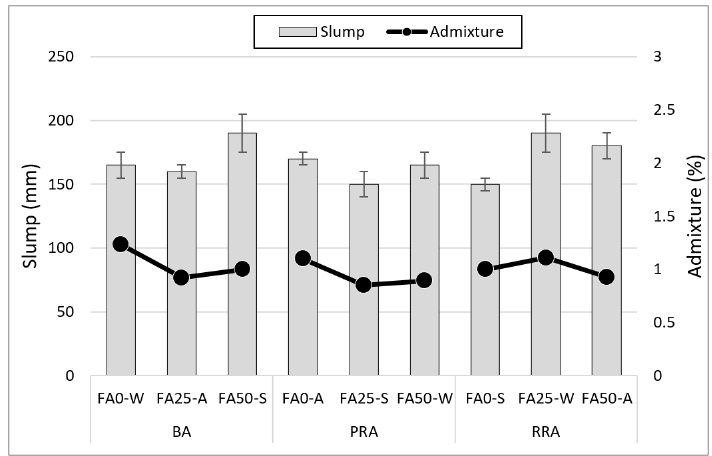
Figure 5. Slump of fresh concrete.